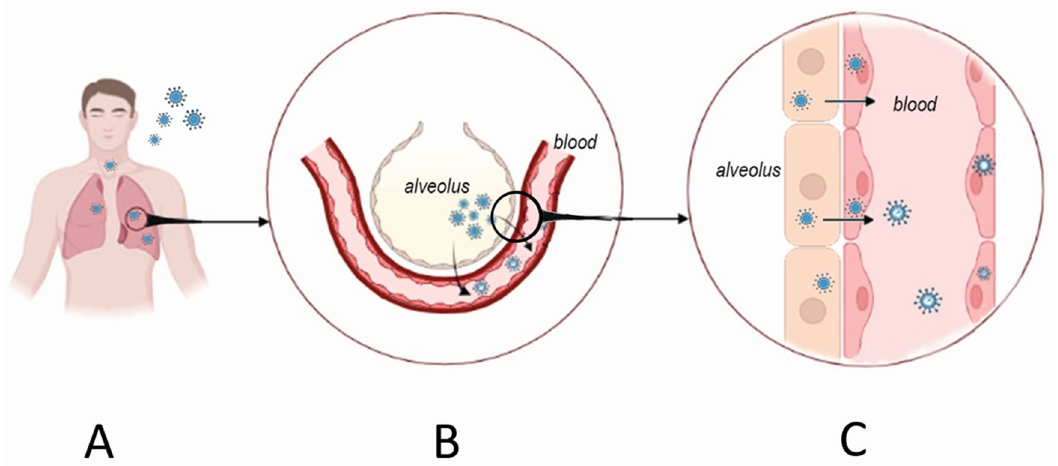
Figure 2. Orthohantavirus infection portal of entry and initial replication sites. Orthohantaviruses use the respiratory tract as one of the portals of entry ( A ). The initial replication site is believed to be in alveolar pneumocytes. From there, the virus crosses the respiratory membrane infecting nearby endothelial cells of the alveolar capillaries ( B ). These steps occur before the patient presents with HFRS symptoms. Once orthohantavirus infects endothelial cells, it becomes released into the blood leading to viremia ( C ). The immune system’s reaction to viremia could cause tissue damage, while increased endothelial permeability and blood coagulation could result from infected endothelial cell activation.